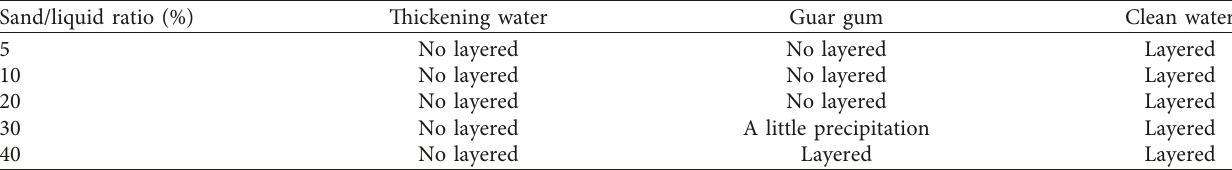
Table 2: Comparison of dynamic sand-carrying capacity of two kinds of fracturing fluids.